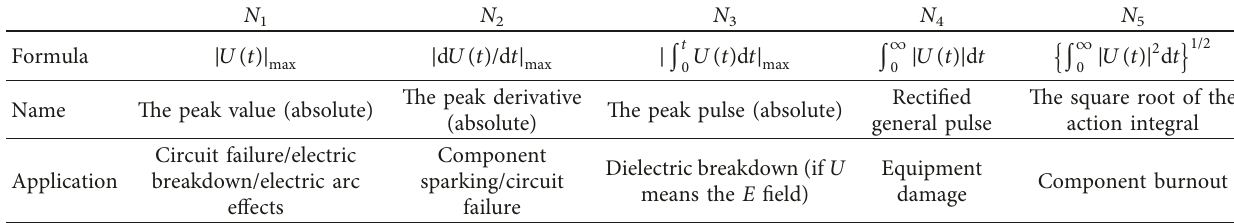
Figure 7: Reflection symmetric structure with triple MR: (a) cross-section and (b) connection diagram. Table 2: N -norms description and